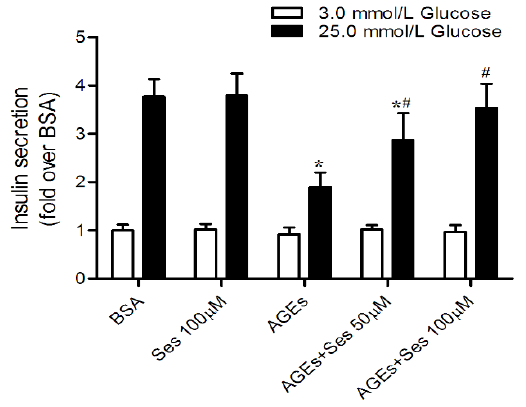
Figure 5. Effects of sesamin on insulin secretion in MIN6 cells. Cells were exposed to 200 mg/L AGEs for 24 h in the presence or absence of sesamin (50 or 100 μ M). The cells were pretreated with sesamin 2 h prior to AGEs stimulation. MIN6 cells were also incubuted with BSA (200 mg/L) as a control. Values are expressed as mean ± SD, n = 4. * p < 0.05 versus BSA. # p < 0.05 versus